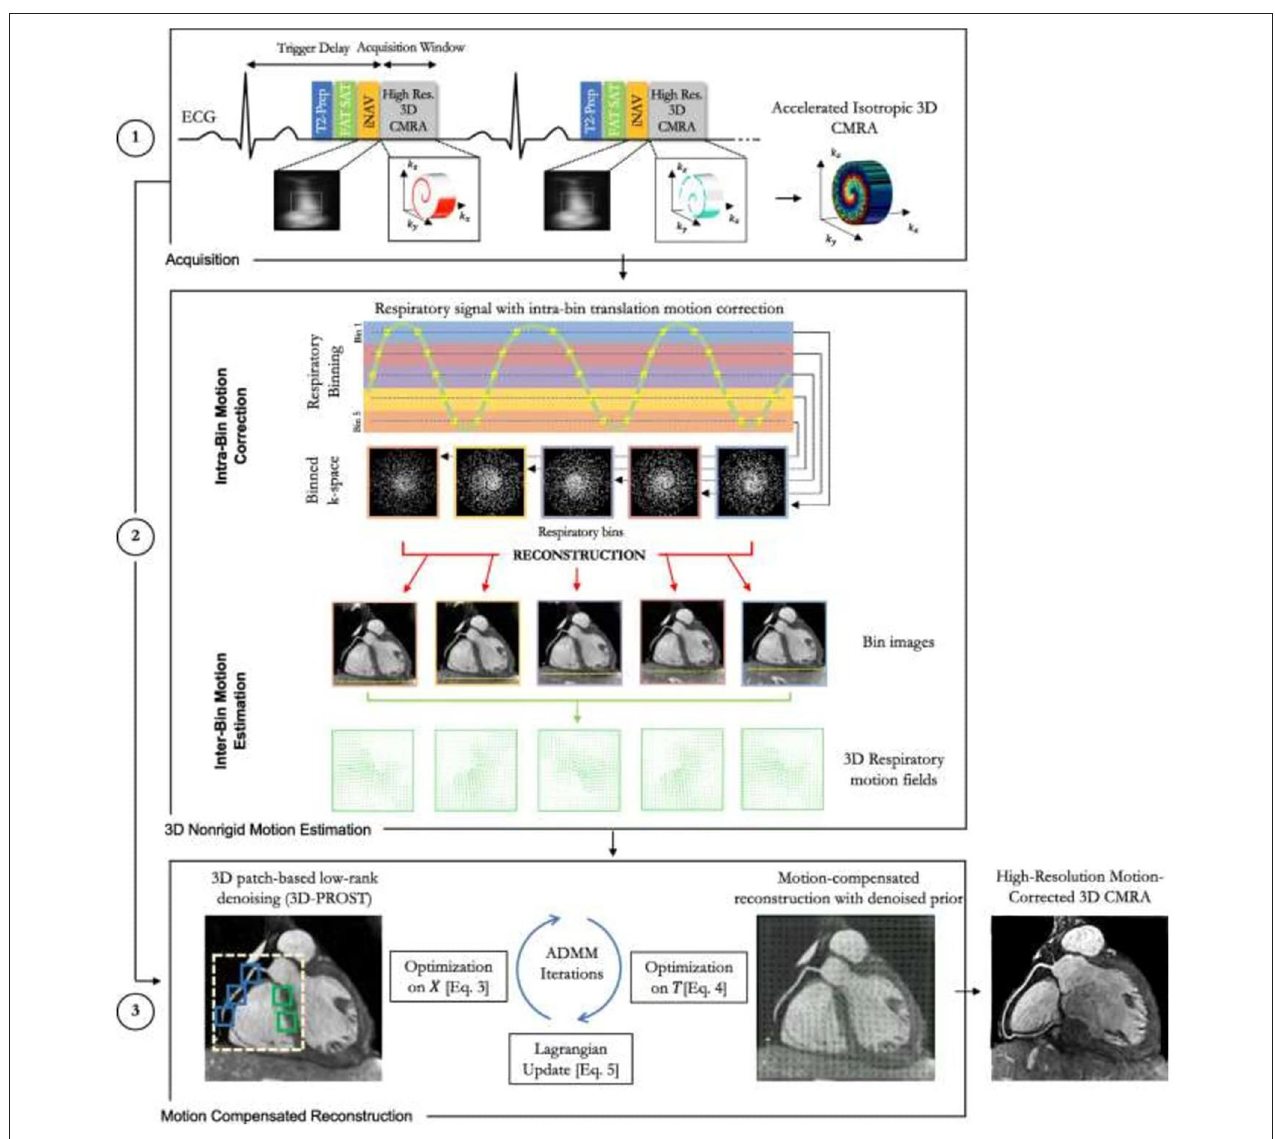
FIGURE 8 | Schematic overview of the accelerated free-breathing 3D CMRA acquisition with sub-millimeter isotropic resolution, 100% scan efficiency and non-rigid motion-compensated PROST reconstruction. ( 1 ) CMRA acquisition is performed with an undersampled 3D variable density spiral-like Cartesian trajectory with golden angle between spiral-like interleaves (VD-CASPR), preceded by 2D image navigators (iNAV) to allow for 100% scan efficiency and beat-to-beat translational respiratory-induced motion correction of the heart. ( 2 ) Foot-head respiratory signal is estimated from the 2D iNAVs and used to assign the acquired data into five respiratory bins and translation-corrected respiratory bins. Subsequent reconstruction of each bin is performed using soft-gated SENSE and 3D non-rigid motion fields are then estimated from the five reconstructed datasets. ( 3 ) The final 3D whole-heart motion-corrected CMRA image is obtained using the proposed 3D PROST non-rigid motion-compensated reconstruction. CMRA, coronary magnetic resonance angiography; PROST, patch-based undersampled reconstruction; ADMM, alternating direction method of multipliers. Adapted with permission from Bustin et al.